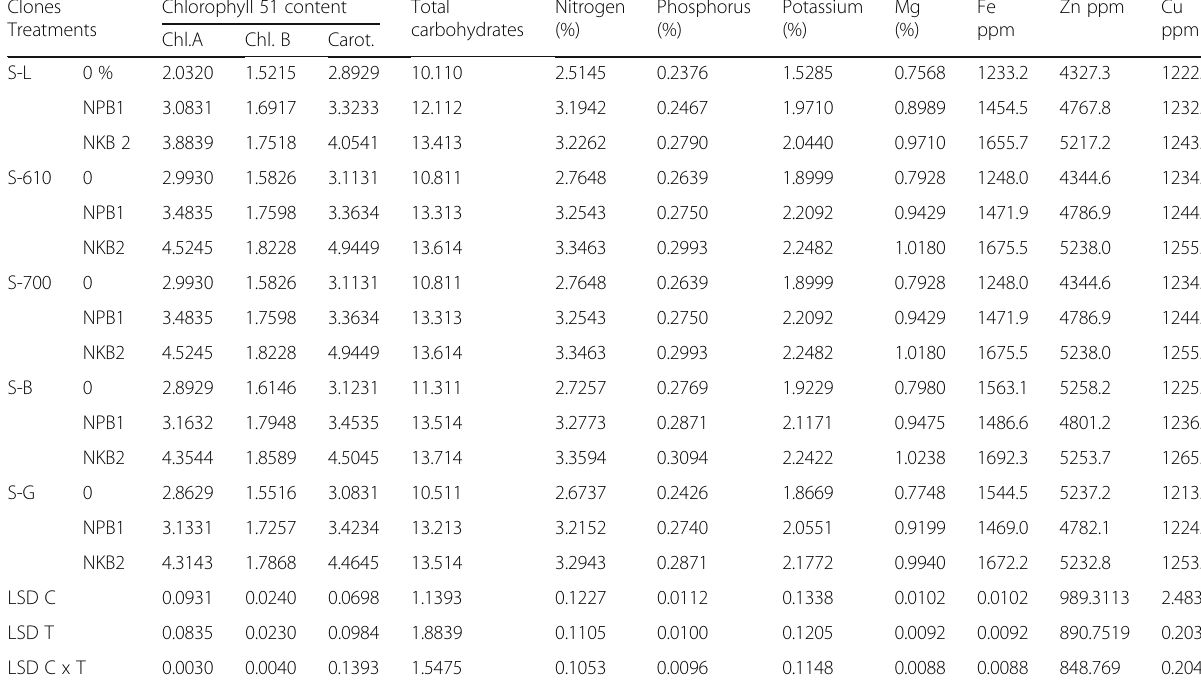
Table 7 Effect of NPB rates on leaves chemical contents of jojoba clones at 13 years Clones Chlorophyll 51 content Total Treatments